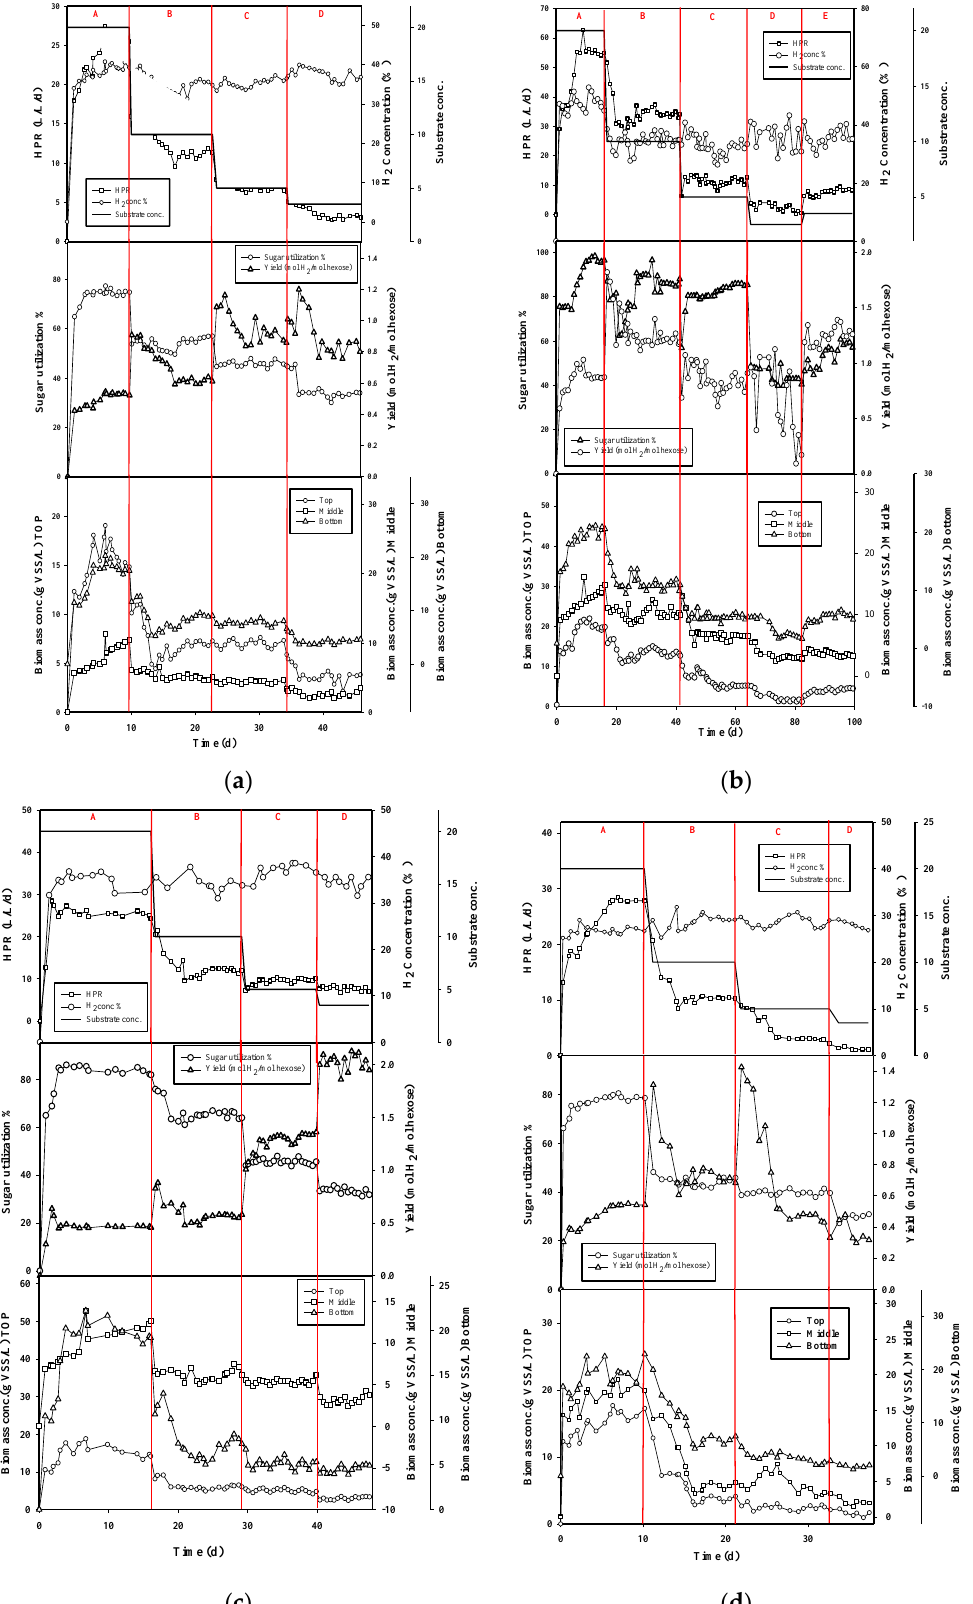
Figure 3. The hydrogen production and biomass concentration evolutions in the four positions from the bottom of the bioreactor: ( a ) h/H 1/4, ( b ) h/H 2/4, ( c ) h/H 3/4, ( d ) h/H 4/4.